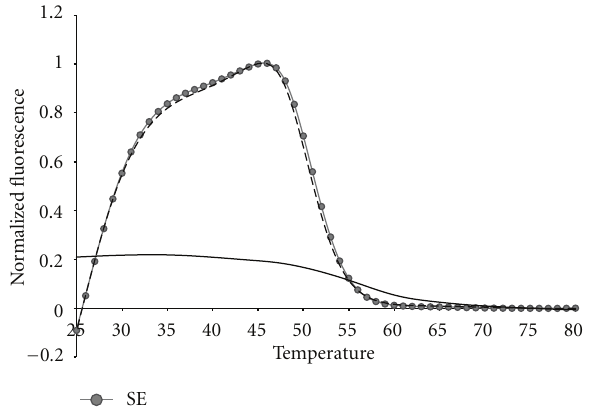
Figure 11: The dashed line shows the fluorescent contour for S. epidermidis plus 35,000 copies of human genomic DNA. As shown, the SE contour is not impacted by addition of human gDNA as it matches the contour for SE alone (- ◦ -). The contour for human gDNA is shown by the solid black